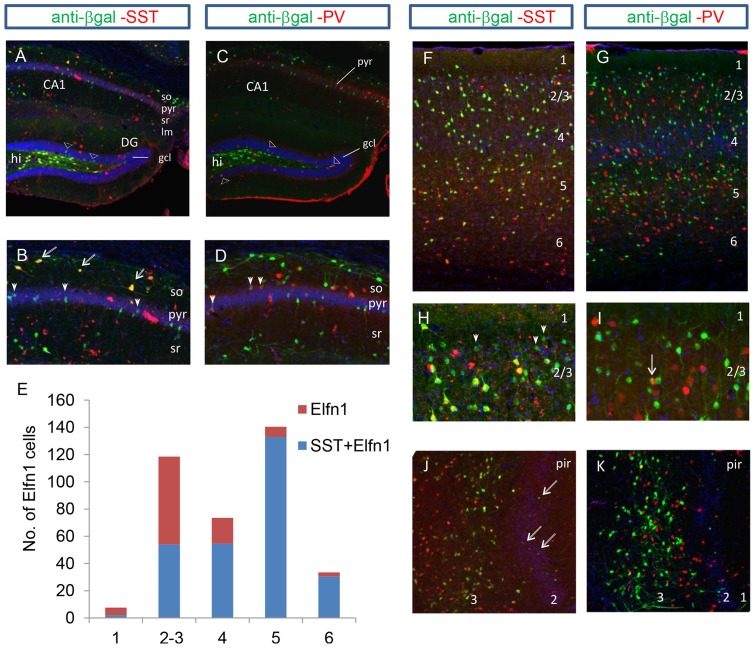
Elfn1 expression in the hippocampus and cortex.(A,B) B shows a close-up of the CA1 region in A. In the adult hippocampus, the β-gal reporter is expressed in the so, pyr, sr and lm layers and also the granule cell layer (A; open arrowheads) and hilus of the dentate gyrus. Double immunoreactivity with β-gal and SST showed co-expression in the so, sr and hilus of the dentate gyrus. Co-expression in the stratum oriens at CA1 occurred in cells with a horizontal orientation (B; arrows) and small vertically orientated cells in the pyramidal cell layer are negative for SST staining (B; closed arrowheads). (C,D) A small number of cells (0.9%) co-labelled for β-gal and PV and were found in so, pyr, sr and gcl (C; open arrowheads) of the dentate gyrus. (D) Close-up of the CA1 region shows double labelling of β-gal and PV in a number of small cells located in the pyramidal cell layer (closed arrowheads). (E) Quantification of the number of cells in each layer of the adult somatosensory cortex that label for both β-gal and SST and cells that express β-gal only. (F,G) Double immunofluorescent staining for β-gal and SST (F) and β-gal and PV (G) across the 6-layered adult somatosensory cortex. (H) Close up of layers 1 and 2/3 in F showing β-gal containing cells that do not express SST, with a smaller cell body than the surrounding double-labelled cells (closed arrowheads). (I) A small number of cells co-express β-gal and PV in the cortex (arrow). (J,K) β-gal-positive cells are most abundant in layer III of the piriform cortex, and in scattered cells in the pyramidal-rich layer II (J; arrows). 77% of β-gal-containing cells were positive for SST while only 3% contained PV. ctx, cortex; CA1, CA1 region of the hippocampus; DG, dentate gyrus; gcl, granule cell layer of the dentate gyrus; so, stratum oriens; sr, stratum radiatum; lm, lacunosum-moleculare; PV, Parvalbumin; Pir, piriform cortex; pyr, pyramidal cell layer; SST, somatostatin.